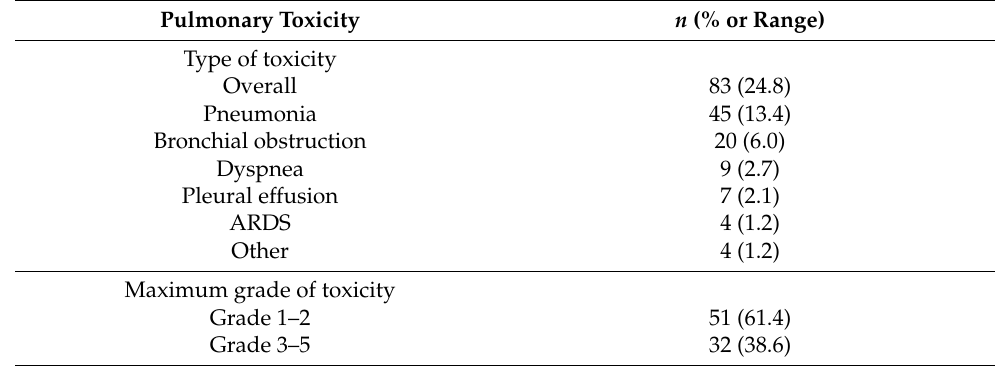
Table 2. Absolute numbers and percentages of patients regarding pulmonary toxicities and grade of toxicities. Multiple toxicities were possible for each patient. ARDS: acute respiratory distress